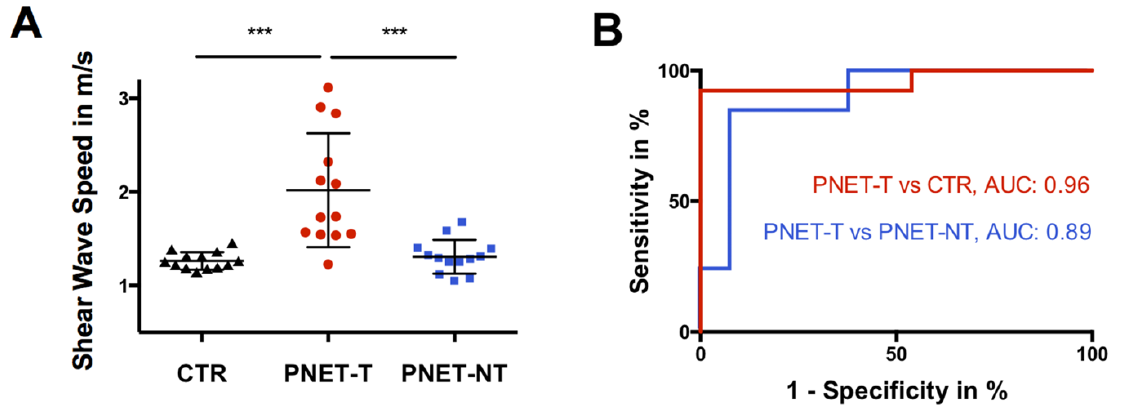
Figure 2. ( A ) Boxplot of shear wave speed (SWS) in m/s of controls (CTR; black triangles; n = 13), tumorous pancreatic region in participants with pancreatic neuroendocrine tumor (PNET-T; red circles; n = 13) and nontumorous pancreas in participants with pancreatic neuroendocrine tumor (PNET-NT; black squares; n = 13). *** p < 0.001. ( B ) Receiver operating characteristic curves for assessing diagnostic performance of shear wave speed in differentiation of PNET-T from CTR and PNET-T from PNET-NT with calculated area under the receiver operating characteristic curve (AUC). PNET-T (1.0 ± 0.17 rad [95%-CI = 0.90 to 1.10 rad]) showed higher compared to